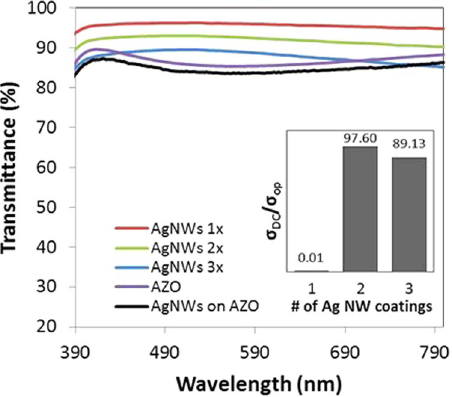
Figure 2. A comparison of the transmittance spectra of Ag NWs with various coating layers, a sputter-coated AZO thin-film, and the composite AZO/Ag NW layer with Ag NWs coated twice. Inset: A plot of the figure of merit ( σ DC / σ op ) vs. the number of Ag NW